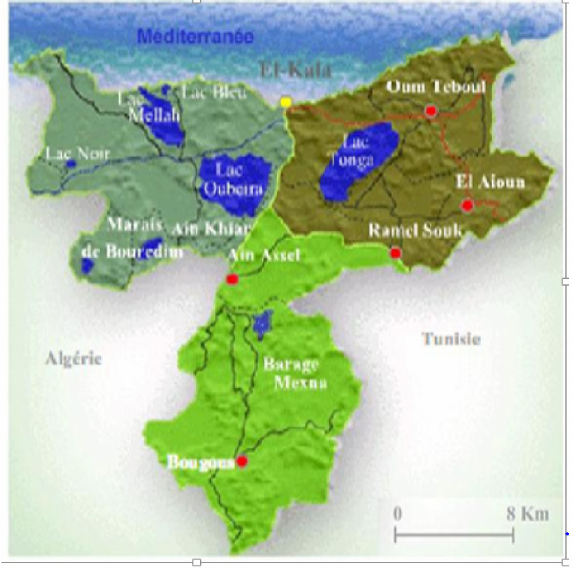
Figure 14. Location of El Kala National Park (P.N.E.K.,